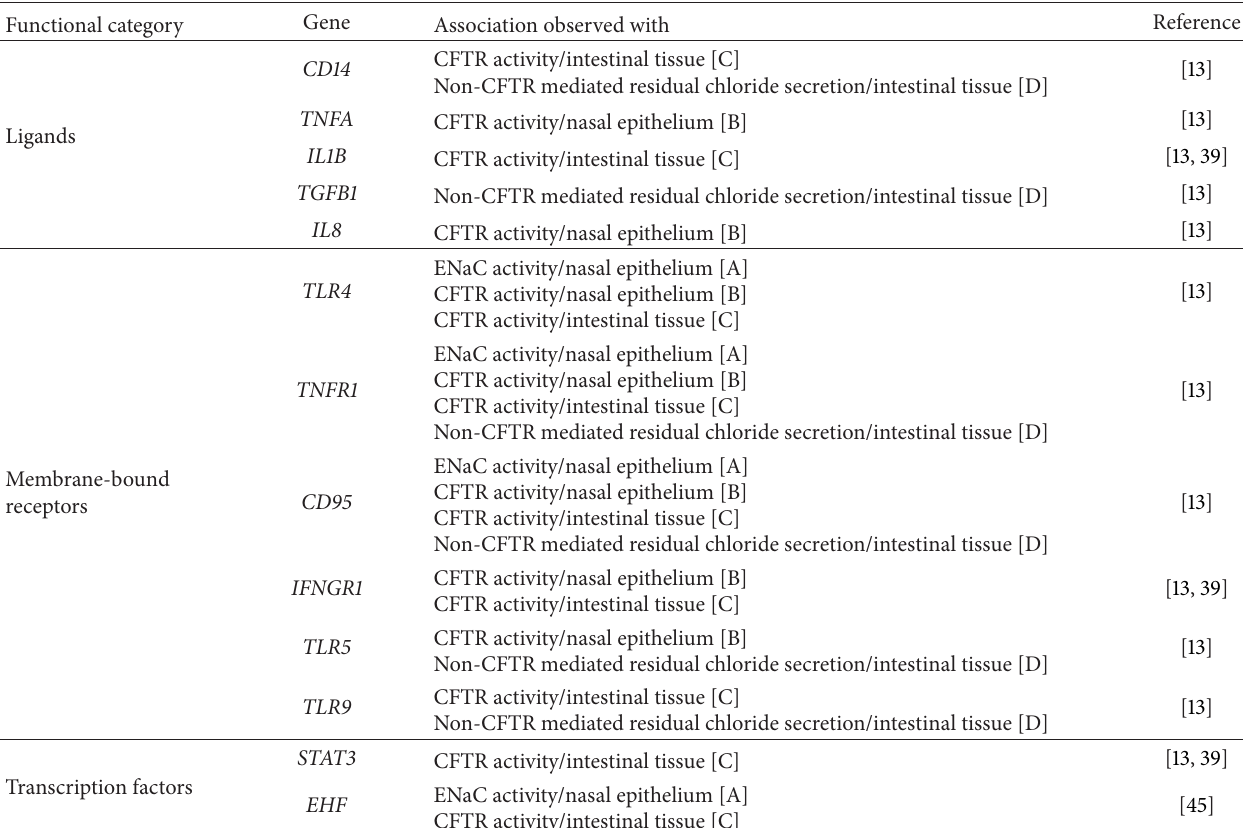
Table 2: Immunologically relevant genes and transcription factors that were identified as modifiers of the CFTR-mediated basic defect among F508del- CFTR homozygous CF